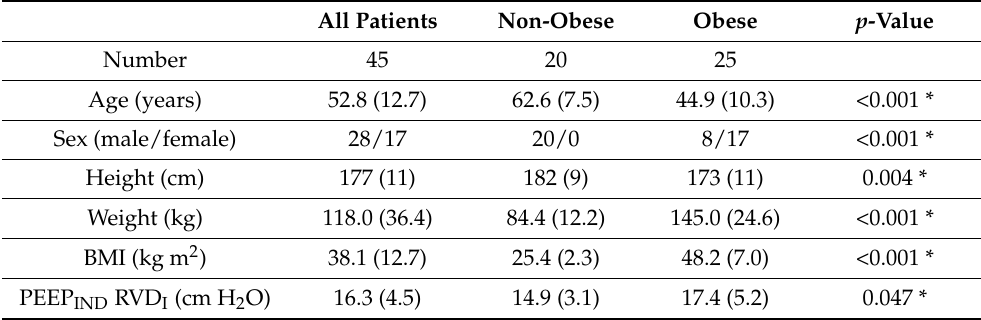
Table 1. Patient characteristics and PEEP IND according to the RVD I method. Entries are mean (standard deviation) or numbers. * p <